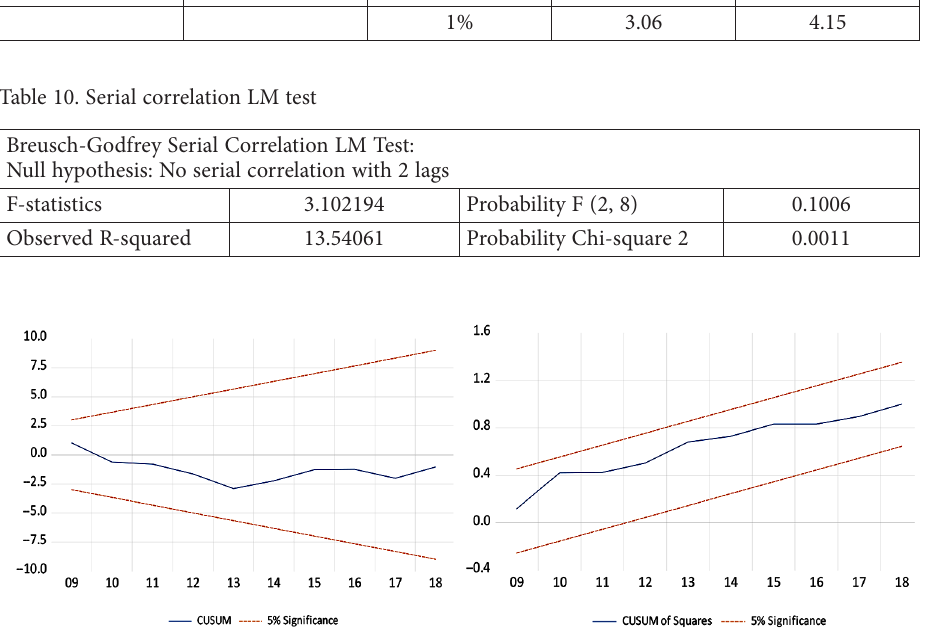
Figure 3. Cusum and Cusun squares stability